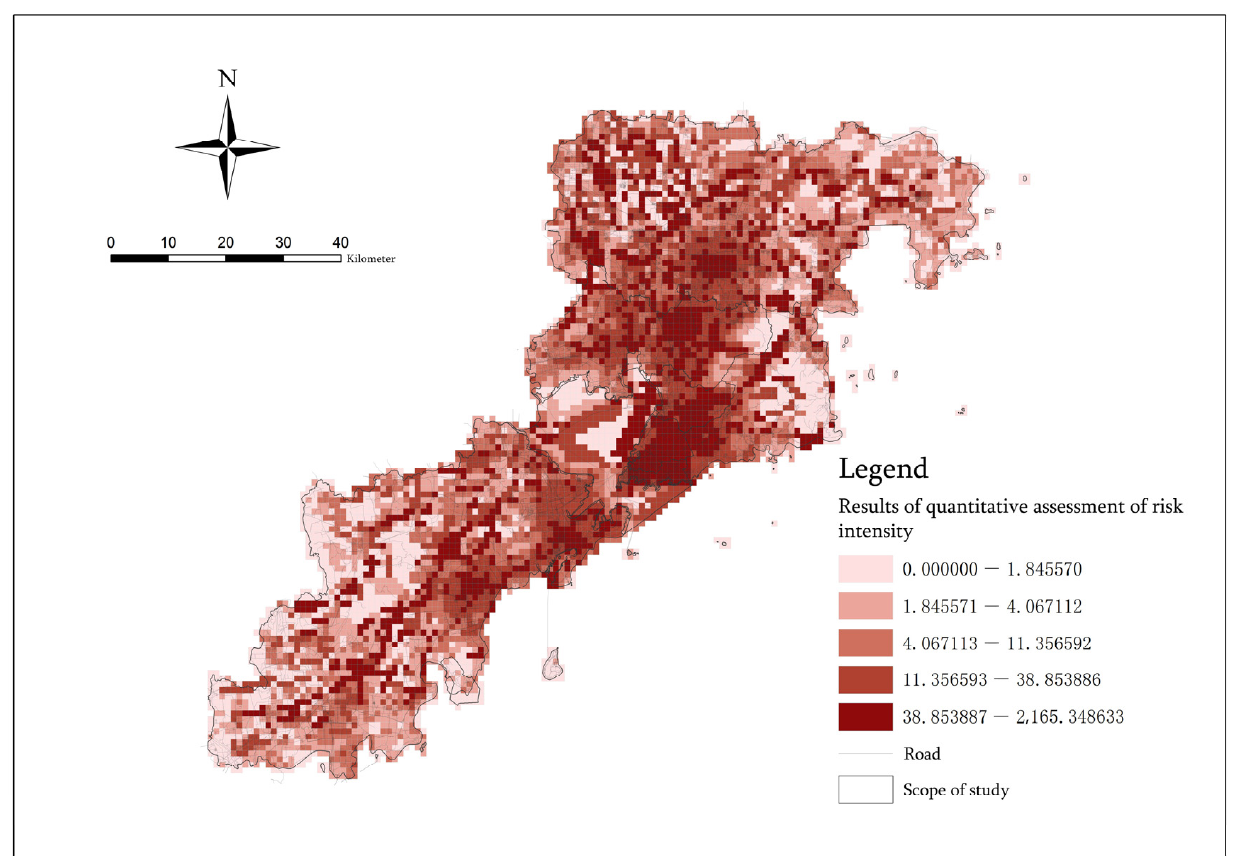
Figure 12. Factor-Weighted Overlay Risk Quantitative Assessment.